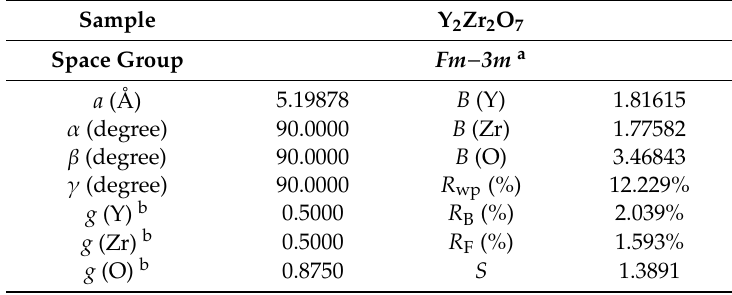
g : occupancy; B : isotropic atomic displacement parameter. a Atomic sites: (Y, Zr) 4 a (0, 0, 0) and O 8 c (1 / 4, 1 / 4, 1 / 4). b Fixed during the refinement. Black points and red lines represent observed and calculated patterns, respectively. Green vertical marks indicate the Bragg reflection positions of defected-fluorite Y 2 Zr 2 O 7 phase. Blue line at